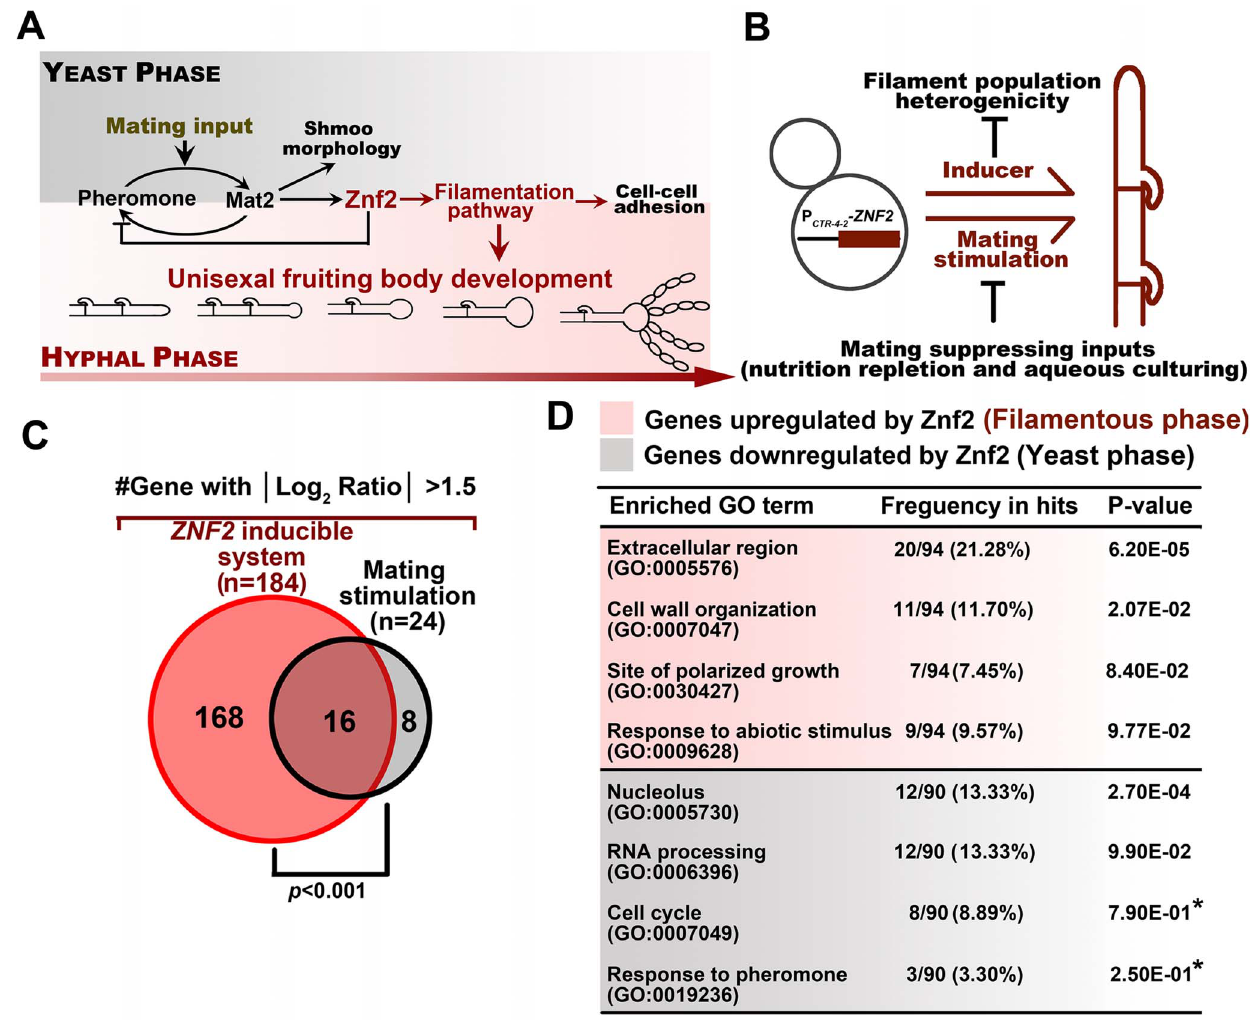
Figure 1. Identification of the genetic network in hyphal and yeast populations. (A) A diagram depicting the pheromone and filamentation signaling pathways and their downstream cellular processes in Cryptococcus . (B) The P CTR4- 2-ZNF2 strain and the wildtype strain H99 were grown under the condition that inhibits mating activation in order to perform comparative transcriptome analyses of homogeneous yeast and hyphal populations without the complication pheromone stimulation. (C) Histogram and the Venn diagram depicting the difference in two transcriptome analyses. The current one (red) used the homogeneous morphotypes and yielded a higher number of genes with significantly differential expression between the yeast and filamentous growth. The former one (black) used wildtype population in response to mating stimulation and the population showed pronounced heterogeneity in cell morphotype, which likely obstructed the previous effort in identifying many of the potential Znf2 downstream targets. The significant overlap of the lists from this study and the previous one verified our current approach and also indicated some factors that are likely to be specific to the growth conditions (hypergeometric p -value of significant overlap , 0.001). (D) The list of enriched GO terms with differentially expressed genes in different morphotypes. The DAVID gene ontology program was used for the analysis and gene-enrichment in the annotated terms was evaluated based on the EASE Score. The EASE Score is a modified Fisher Exact P-Value and the default threshold is 0.1 [29]. Asterisks indicate GO terms with values above the default threshold. These GO terms are included because of their potential biological significance based on previous studies in C. neoformans or other fungi [11,12,30,47]. The extremely mating-suppressive conditions used in this study may result in the under-representation of these classes and their lower statistical